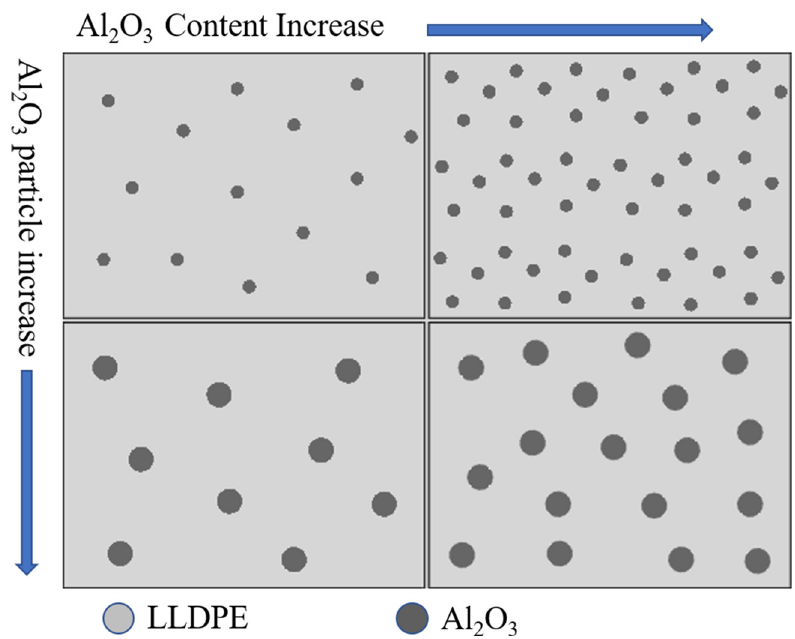
Figure 6: Diagrams of Al 2 O 3 morphology with di ff erence particle diameters and contents in the